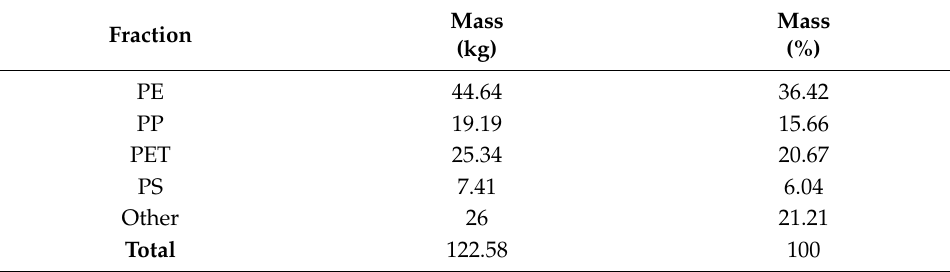
Table A2. Plastic type content of P determined by sensor-based sorting with